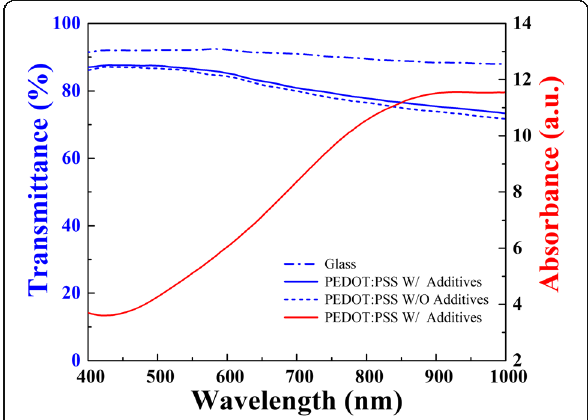
Fig. 3 The red line is the absorbance spectrum of PEDOT:PSS with additives(DMSO and FS31) at wavelength from 400 to 1000 nm. The blue lines are the transmittance spectra of PEDOT:PSS film with and without additives and reference glass at wavelength from 400 to 1000 nm,